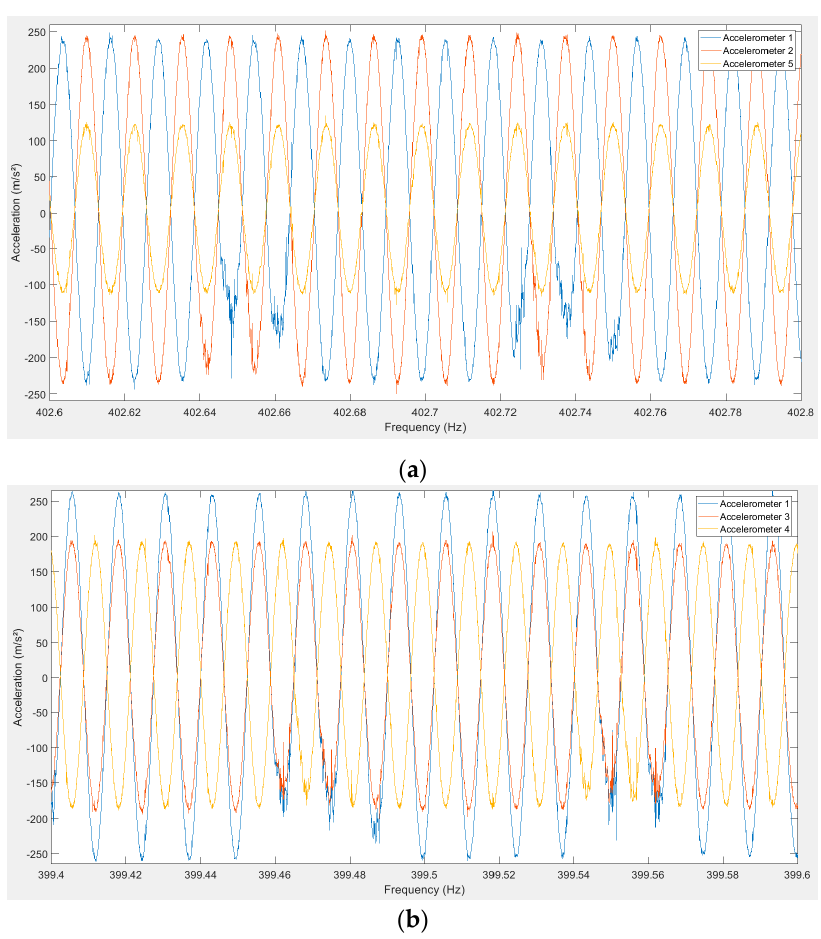
Figure 4. Acceleration at resonance during sweep from 375 to 425 Hz in 10 s all actuators in phase at 136 Vpp for ( a ): accelerometer 1, 2 and 5 and ( b ): accelerometer 1, 3 and 4. 136 Vpp for ( a ): accelerometer 1, 2 and 5 and ( b ): accelerometer 1, 3 and